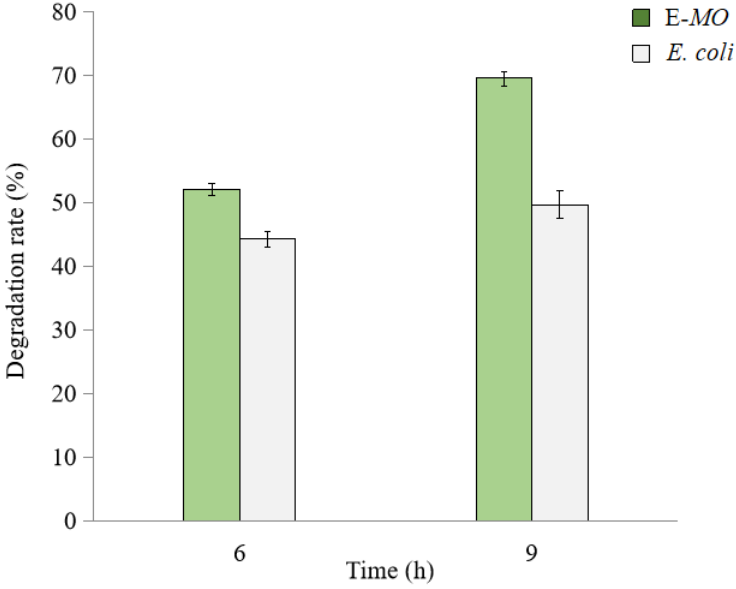
Figure 5. TNT degradation by wild type E. coli (gray) and the E- MO (green) mutant. TNT degradation was assessed after 6 h or 9 h, respectively. Data are presented as mean of N = 4, x ± SD. Statistical significance is denoted as p < 0.05 using